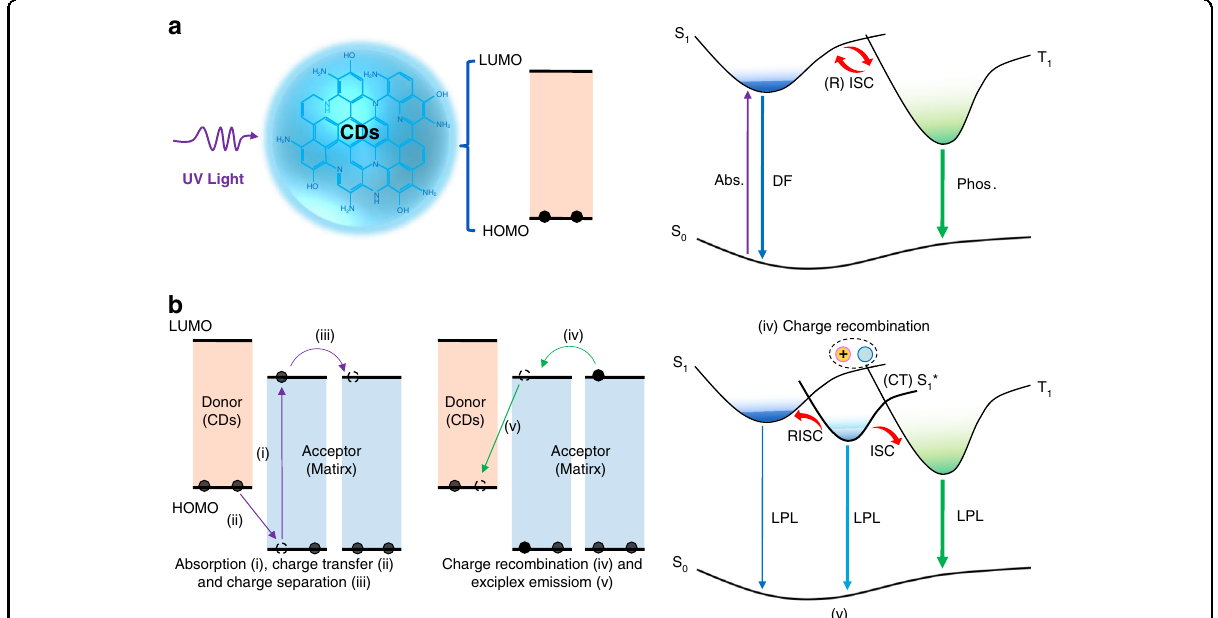
Fig. 1 Possible mechanisms for achieving long-lived luminescence from CDs. a The emission mechanism of delayed fl uorescence (DF) and phosphorescence: upon photoexcitation, electrons are excited from the ground state (S 0 ) to the excited singlet state (S 1 ) and then undergo intersystem crossing (ISC) to form the excited triplet state (T 1 ), from which electrons relax to S 0 by emitting phosphorescence; alternatively, electrons can return to S 1 by reverse ISC (RISC) and then relax to S 0 by emitting DF. Phosphorescence was abbreviated as Phos in this fi gure for clarity. b A possible LPL mechanism: during photoexcitation, electrons (black dots) are continuously generated and fi lled into the LUMO orbits (path i; the black dashed circle representing possible hop positions of electron, the same below); in the blends of CDs and matrix, electrons are transferred from the HOMO of the donor to the HOMO of the acceptor to form charge-transfer (CT) states (path ii); formation of the charge-separated (CS) states through diffusion and isolation of the donor radical cations (CDs) into the acceptor radical anions (matrix) (path iii); gradual recombination of the radical anions and radical cations (path iv) to generate long persistent exciplex emission, electronic transition from the LUMO of the acceptor to the HOMO of the donor (path v). The small energy gaps between the lowest singlet excited state of exciplex (S 1 *) and S 1 /T 1 of CDs enable RISC and ISC, resulting in multiple LPL emission